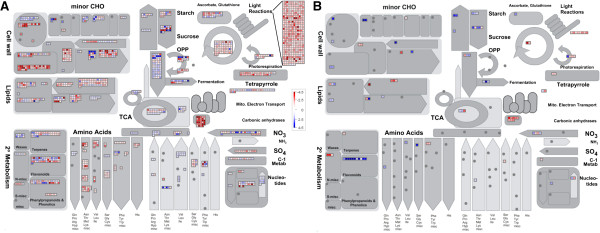
An overview of cold responsive genes annotated in MapMan functional groups for primary and secondary metabolism. Comparison of (A)T. salsuginea and (B)Arabidopsis genes encoding proteins involved in primary and secondary metabolisms. Samples derived from T. salsuginea Yukon were hybridized against T. salsuginea arrays, samples derived from Arabidopsis Col-0 to Arabidopsis arrays. Differential gene expression was determined in response to 14 days of cold acclimation at 4°C. Significance of expression changes was determined with a threshold of p < 0.05 after false discovery correction by fitting the data to a linear model. Blue indicates significantly up-regulated and red significantly down-regulated genes. Note the large difference in the number of regulated genes in the light reactions bin between the two species.